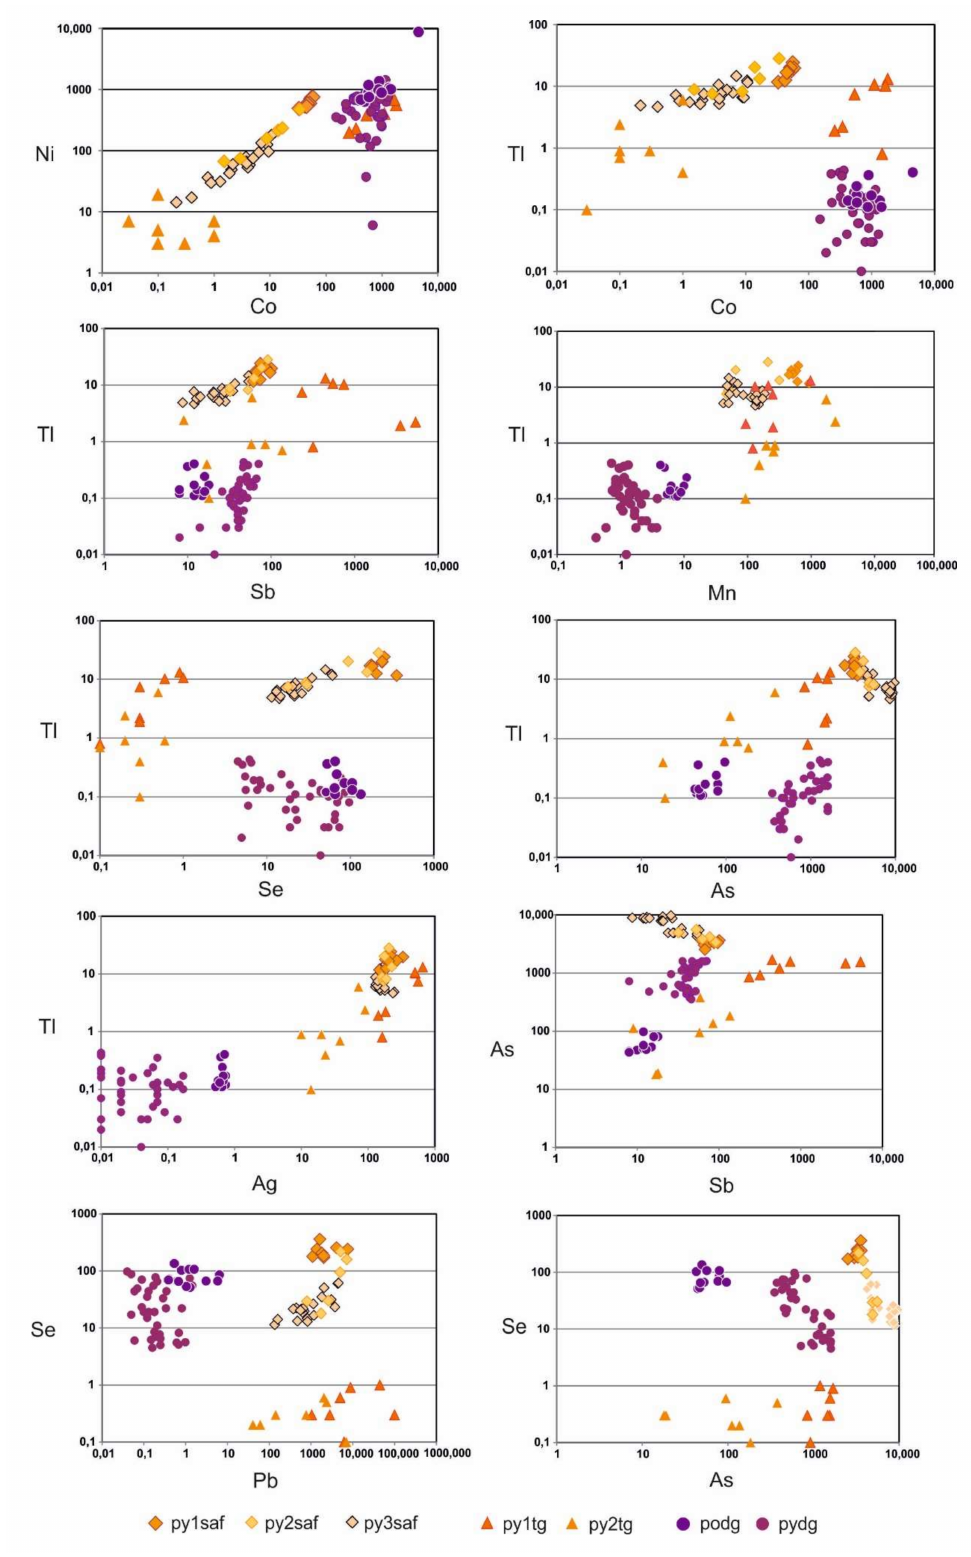
Figure 7. Correlation between selected trace elements in pyrite nodules of the Saf’yanovskoe (rhombs), Talgan (triangles), and Dergamysh (circles)